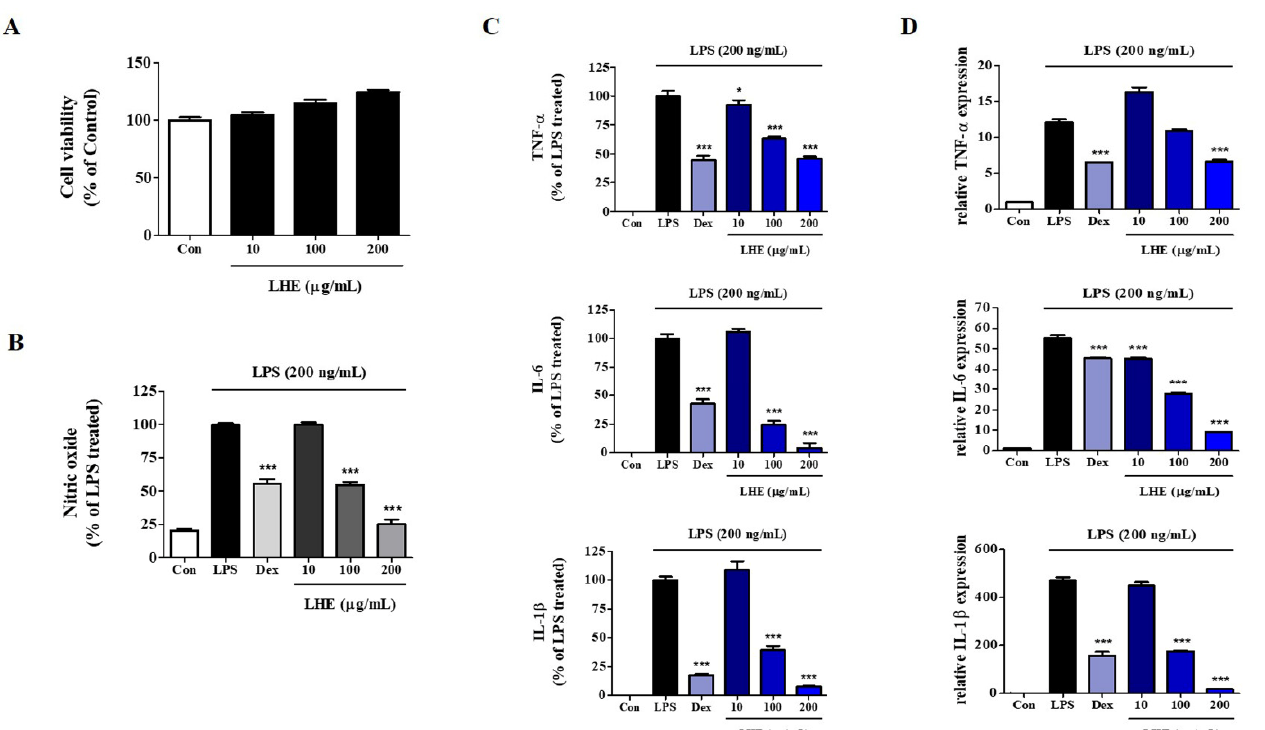
Figure 1. Effects of LHE on ( A ) cell viability, production of ( B ) NO and ( C ) inflammatory cytokines, and ( D ) expression of their mRNA in LPS-stimulated RAW 264.7 macrophages. Control cells were incubated with vehicle alone. Data were presented as mean ± SEM of determinations from three independent experiments. * p < 0.05 and *** p < 0.001 were calculated by comparing LPS stimulation values.